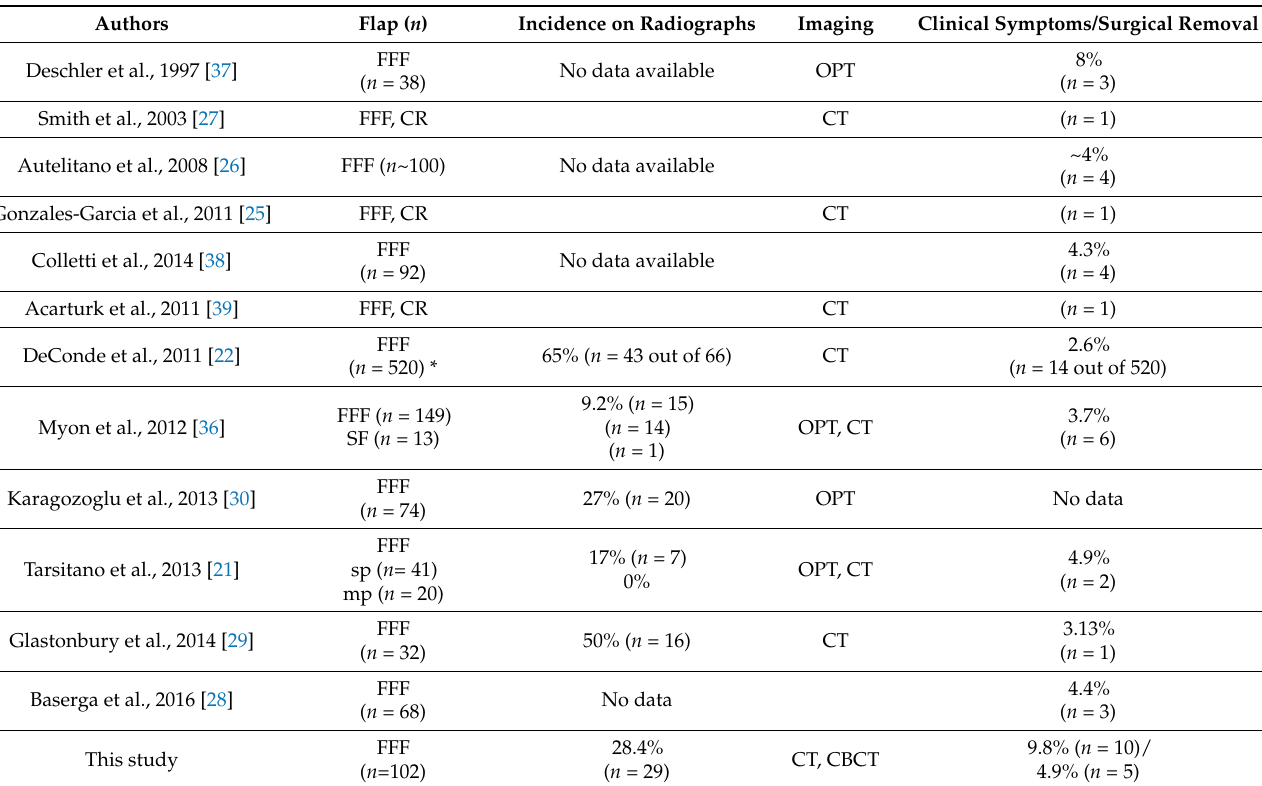
Table 3. Heterotopic ossification (HO): overview published